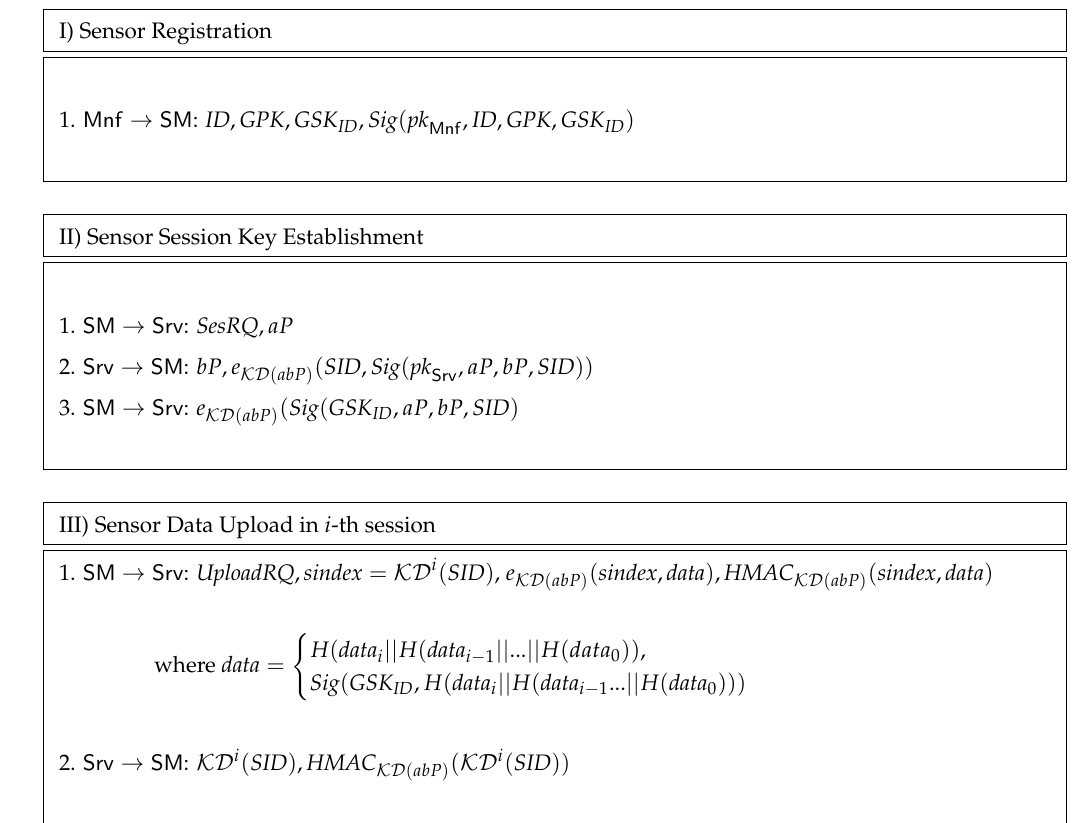
Figure 3. Protocols for sensor registration, session key establishment, and data